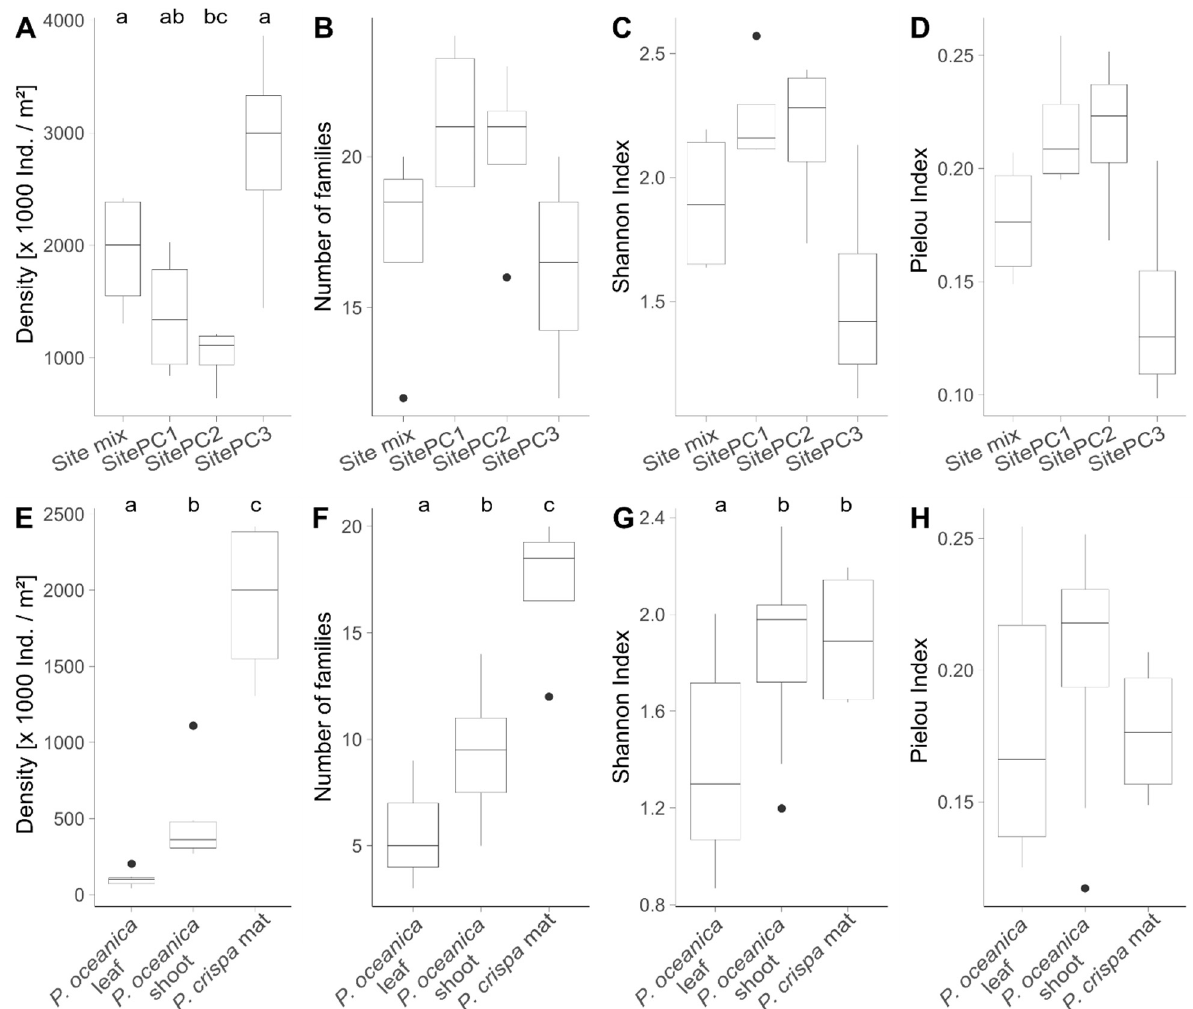
Figure 4. Comparison of abundance and diversity descriptors among sites and habitats. First row ( A – D ): all four investigated Phyllophora crispa sites in 2019. Second row ( E – H ): all three (sub-) habitats on the northern sites (Site Mix, site PC1, site PC2) in 2019. Columns show the density of colonies per m² seafloor, number of identified taxa, Shannon index, and Pielou’s index. Statistical differences ( p < 0.05; Wilcoxon–Mann–Whitney test) are indicated by small letters (a–c) where significant results occurred. Black dots resemble outliers.